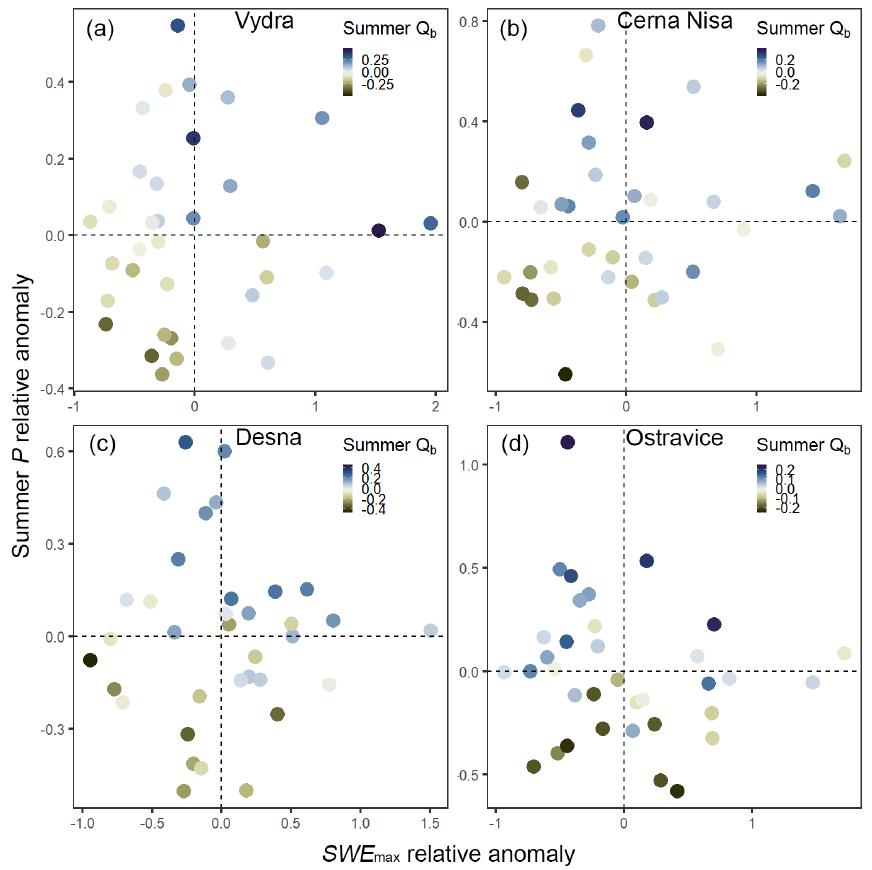
Figure 6. Dependence of summer baseflow ( Q b ) relative anomalies on SWE max and summer (JJA) precipitation relative anomalies at four selected catchments. (a) Vydra (Bohemian Forest), (b) ˇCerná Nisa (Western Sudetes), (c) Desná (Eastern Sudetes), (d) Ostravice (Western Carpathians).